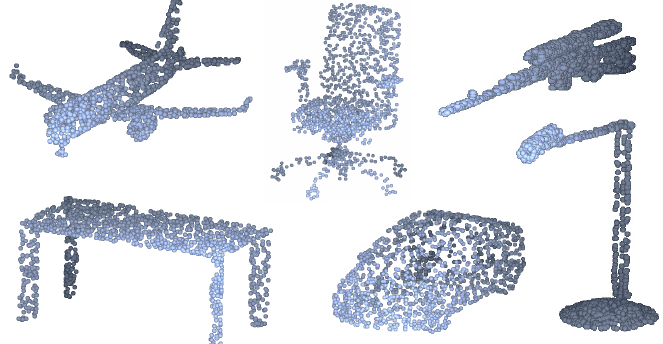
Figure 5. Point clouds sampled from 3D objects in the ModelNet40 dataset. All point clouds are normalized into a unit sphere for convenience.